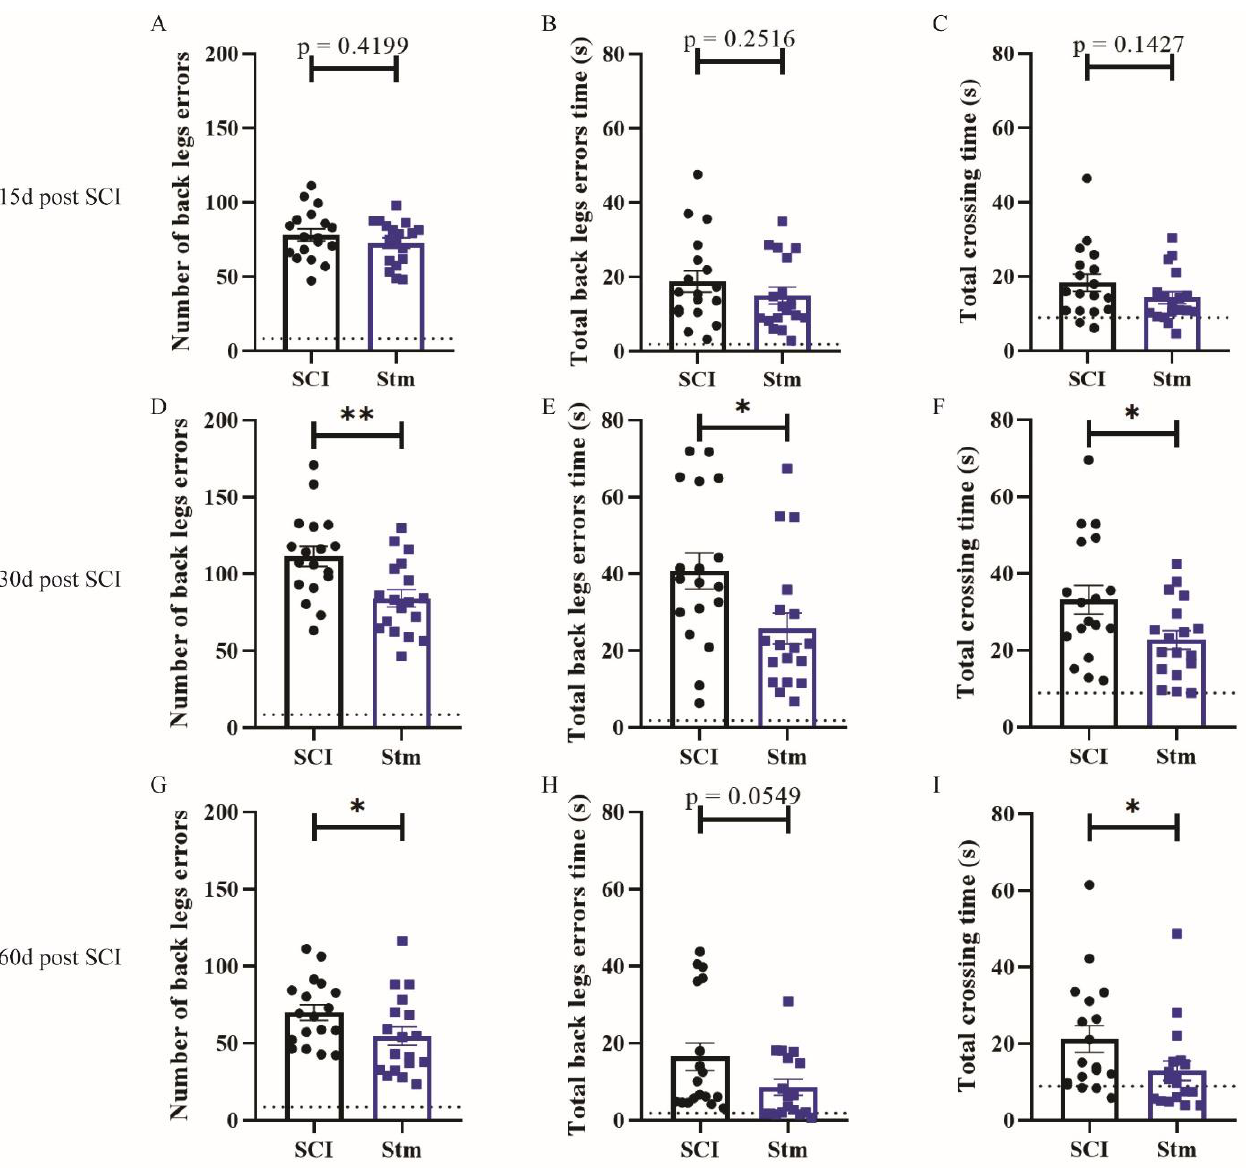
Figure 2. rTSMS treatment induces locomotor recovery after a complete transection of the spinal cord in rats. Quantification of locotronic evaluation at ( A – C ) 15 days, ( D – F ) 30 days and ( G – I ) 60 days after SCI. Parameters are ( A , D , G ) number of back-legs errors, ( B , E , H ) total back-legs errors’ time and ( C , F , I ) total crossing time. Quantifications are expressed as average ± SD; n = 18 animals per group. Dashed lines correspond to the baseline parameters obtained during locotronic habituation (7 days before SCI). Quantifications are expressed as average ± SD. Statistical evaluations are based on the Mann–Whitney test (* = p < 0.05 and ** = p < 0.01).